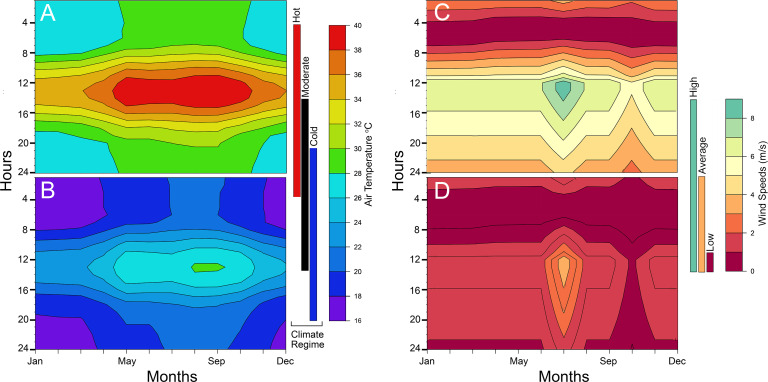
Heatmaps of microclimate air temperature and wind speed at average animal height for each modeled hour.We use a turbulent velocity and temperature profile where the most significant changes occur within the first 15 cm from the ground. The microclimates are the same for both Coelophysis (shown) and Plateosaurus. (A) hot and B) cold climate regimes, C) high and D) low wind speeds.